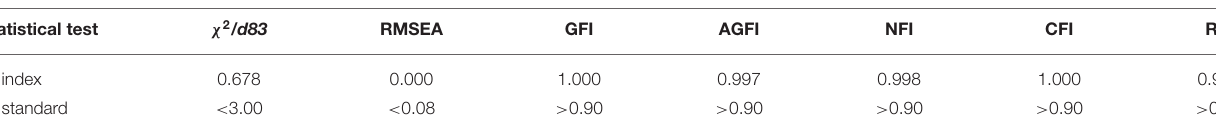
TABLE 5 | Model fitting